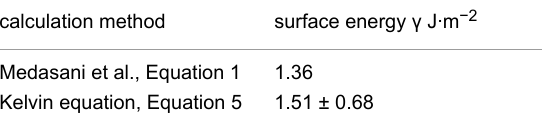
Table 3: Surface energy γ of the glassy (most stable) Au 55 cluster de- termined by two different methods. The confidence range for γ ob- tained by application of the Kelvin equation is 3 σ